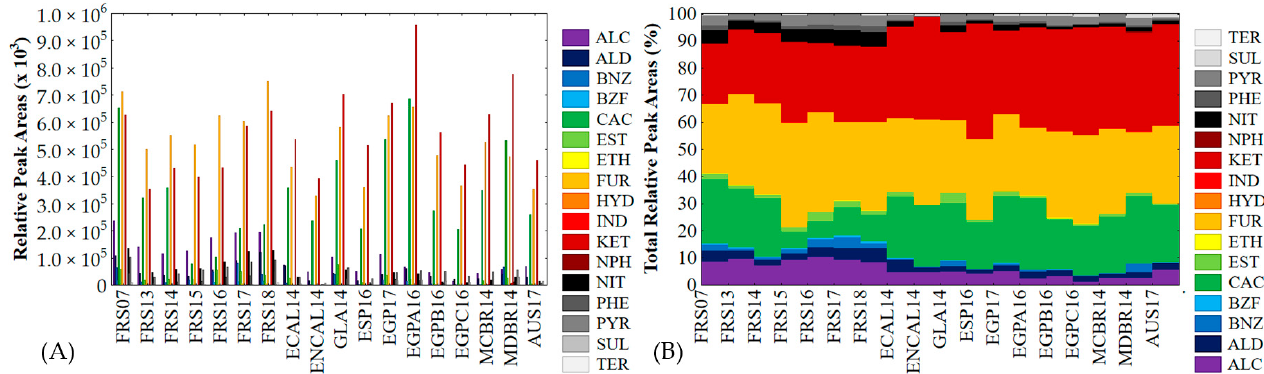
Figure 2. The contribution, relative peak area ( A ) and % total relative peak area ( B ) values of each chemical class group for all samples.